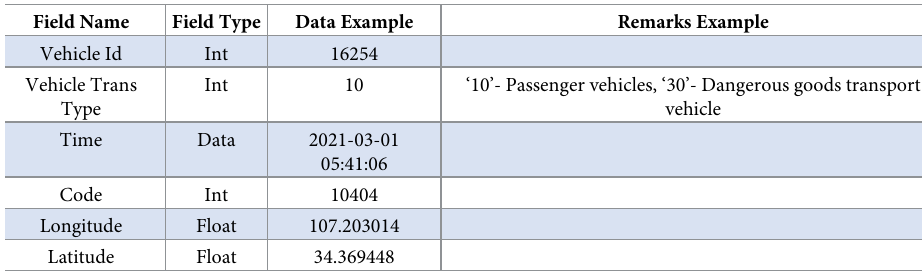
Table 1. Distracted driving behavior data